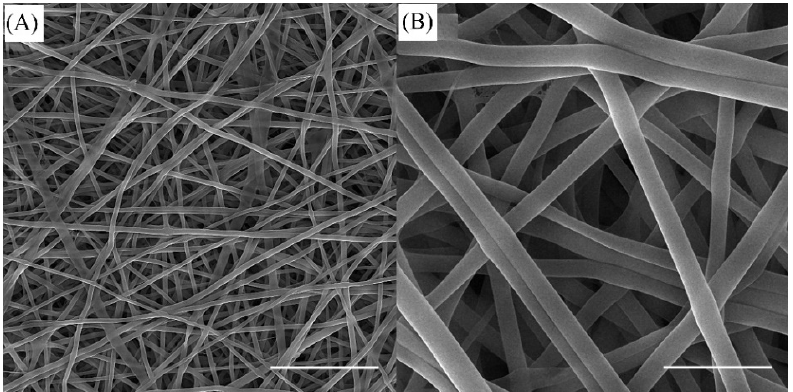
Figure 1. SEM images of hybrid electrospun SF/k-CG nanofibers. Scale bar is 10 µm ( A ) and 2 µm ( B ), respectively.